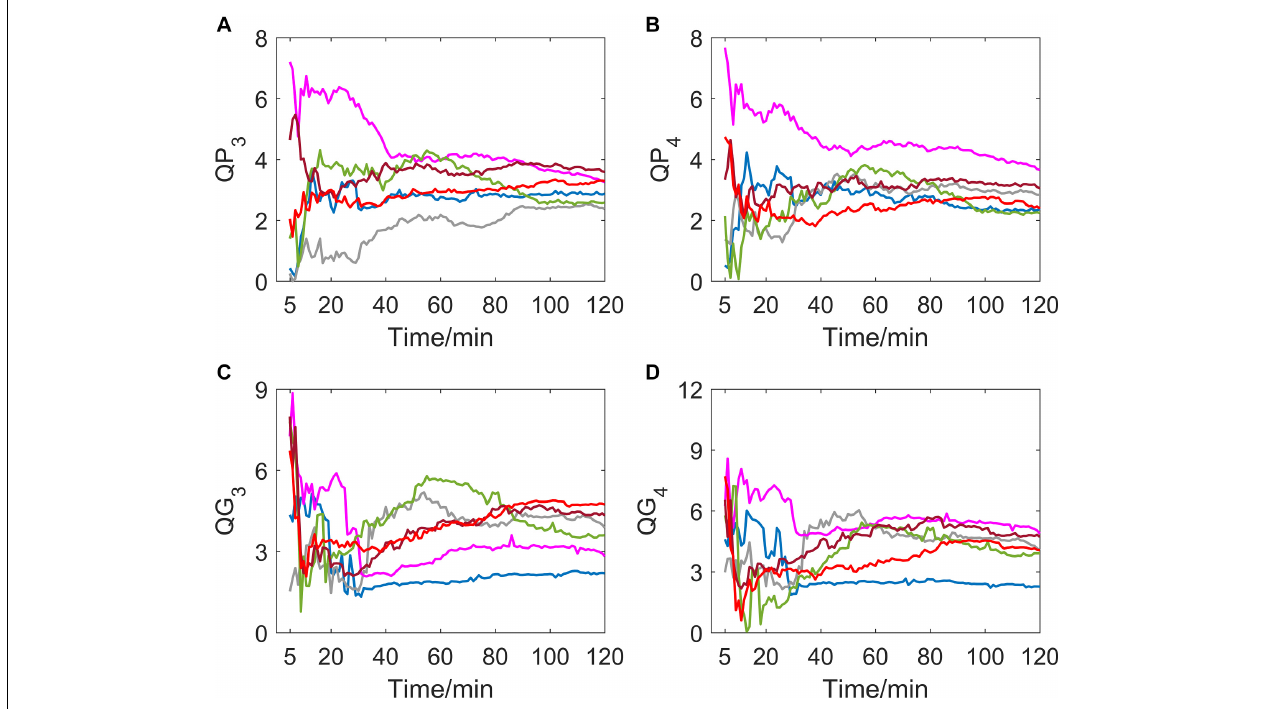
FIGURE 4 | (A–D) show the corresponding results of QP 3 , QP 4 , QG 3 , and QG 4 . Variation tendency of QP 3 , QP 4 , QG 3 , and QG 4 within 2 h of hypoxic group.